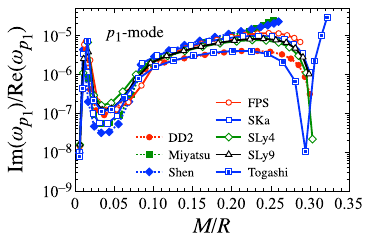
Fig. 3 The ratio of Im( ω ) to Re( ω ) for the p 1 -mode is shown as a function of the stellar compactness for various neutron star models